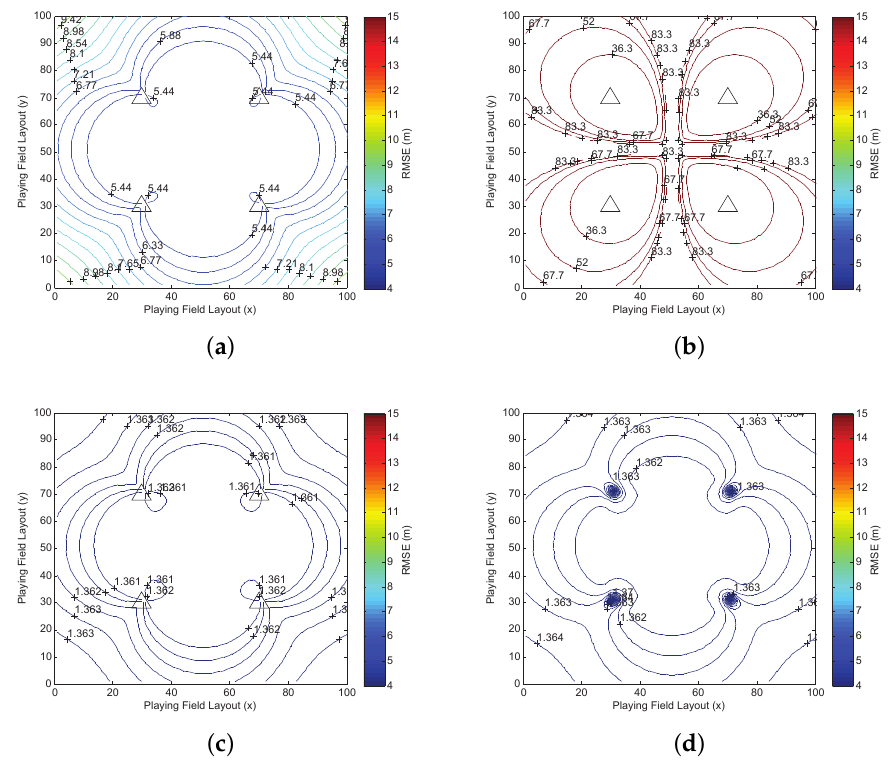
Figure 2. The spatial position error distribution (SPED) results of the CRLB with and without prior information. ( a ) The SPED of CRLB x SPED of CRLB x t , k t , l x t , k t , l